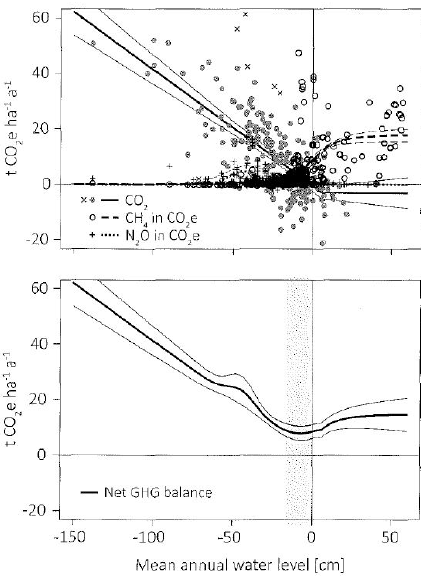
Figure 3. GHG emissions and net GHG balance of peatlands de- pend on the average annual water table. The hairline graphs illus- trate the 95% confidence intervals, respectively (Jurasinski et al., 2016).